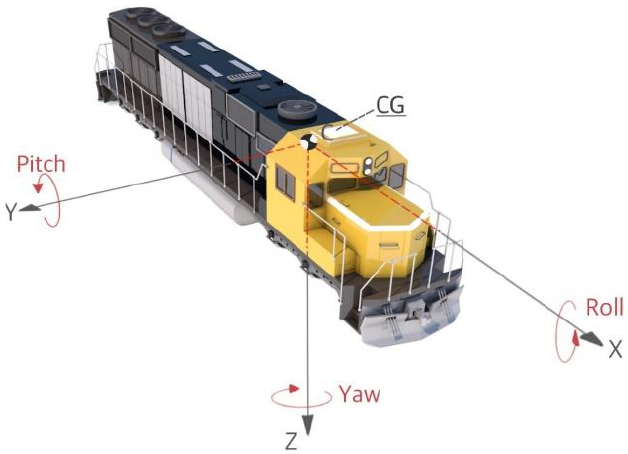
Figure 17. Dynamic behavior of the vehicle.